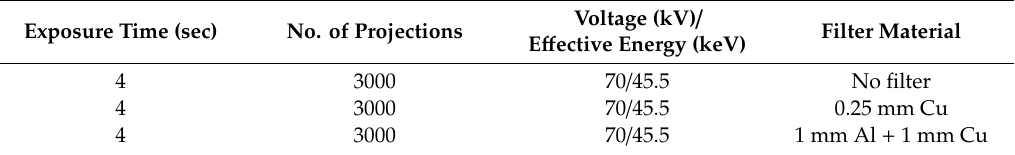
Table 1. Scanning parameters to optimize discrimination between